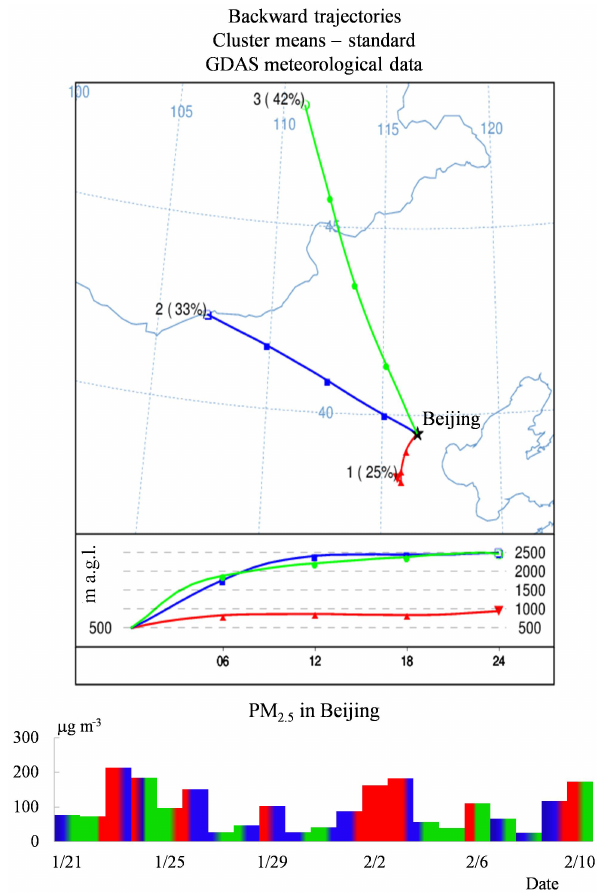
Figure 8. The back trajectory cluster analysis and the corresponding PM 2 . 5 concentrations in Beijing during the sampling period in the winter of 2015.